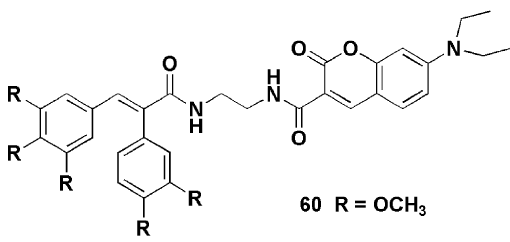
Figure 16. Chemical structure of compound 60 [49].